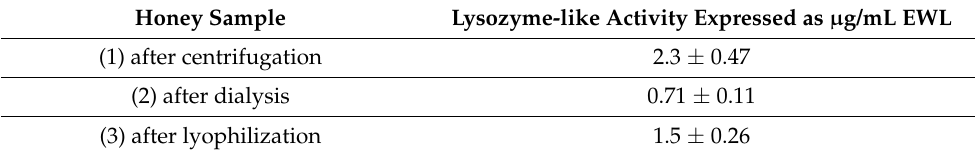
Table 3. Lysozyme-like activity in honey